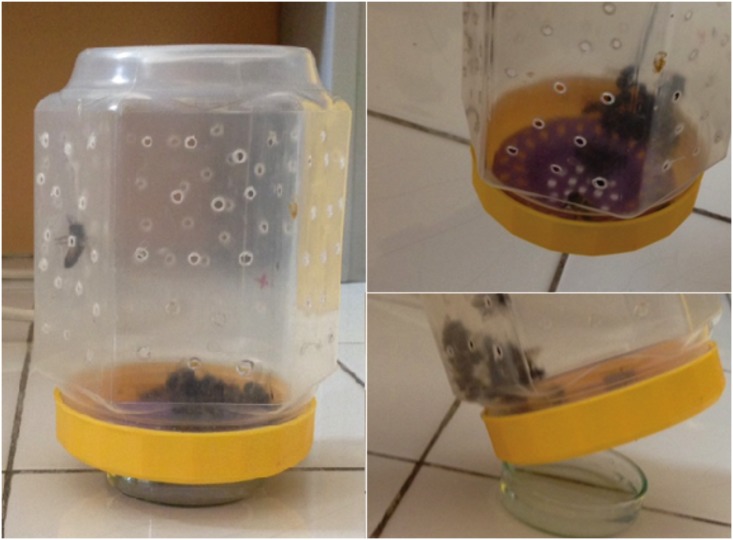
The modification of a laboratory cage: A plastic jar with small holes made for aeration and a plastic mesh sink strainer inserted into the lid allowing bees to take the food from a small petri dish placed below.